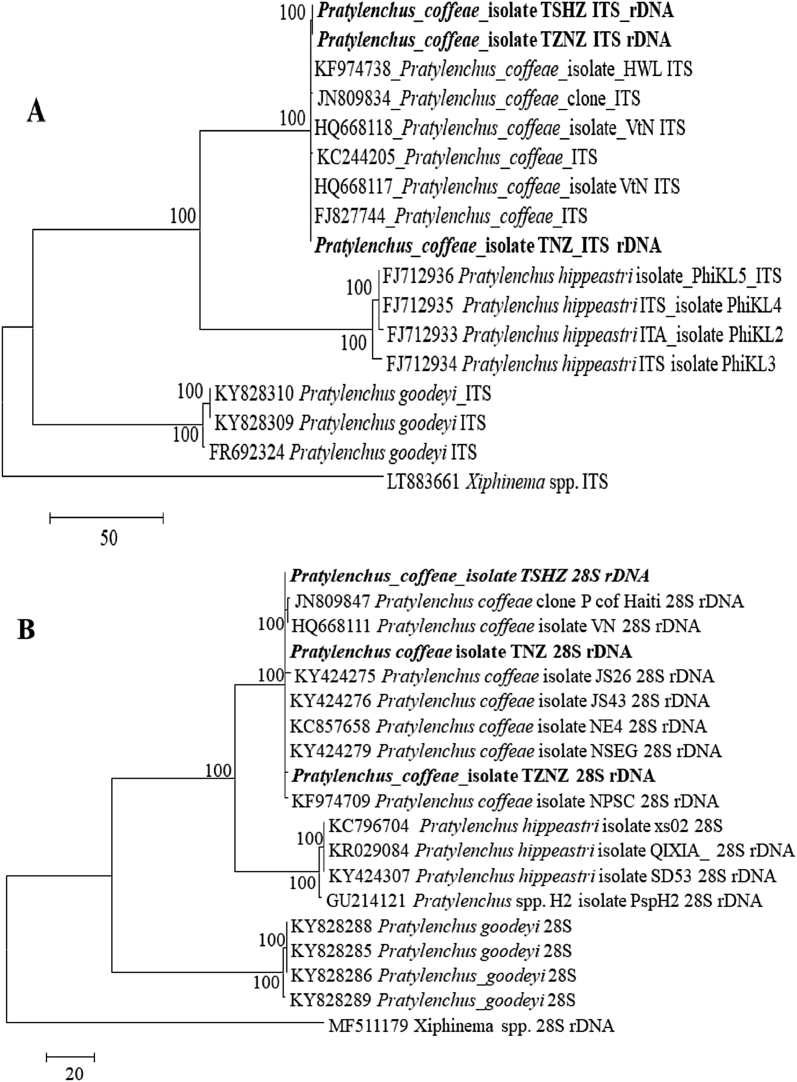
Phylogenetic relationships of Pratylenchus coffeae populations with other Pratylenchus spp. as inferred from maximum parsimony analysis of ITS (1 and 2) linked by 5.8S (A) and 28S (B) gene sequences of rDNA region.